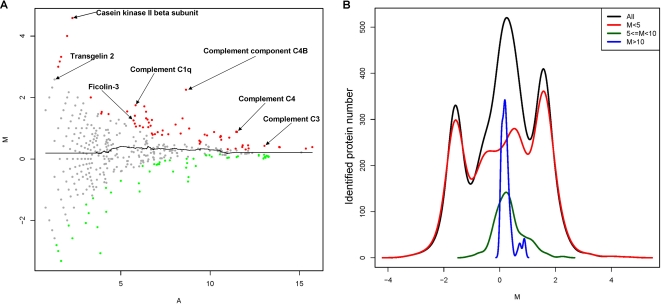
Quantitative strategy of proteins in non-diabetic and diabetic serum.(A) M-A plotting of 1377 identified proteins. “M” was defined as differential protein abundance ratios of each protein between diabetic and non-diabetic serum, and “A” was defined as protein-abundance of each protein. In addition, ret dots represented statistically significant over-represented proteins in diabetic serum, green dots represented statistically significant under-represented proteins in diabetic serum, and grey dots were proteins without statistically-significant change in diabetic serum and non-diabetic serum. (B) The distribution profiles of 1377 identified proteins (black line), identified proteins with M less than 5 (red line), between 5 and 10 (green line), and more than 10 (blue line).